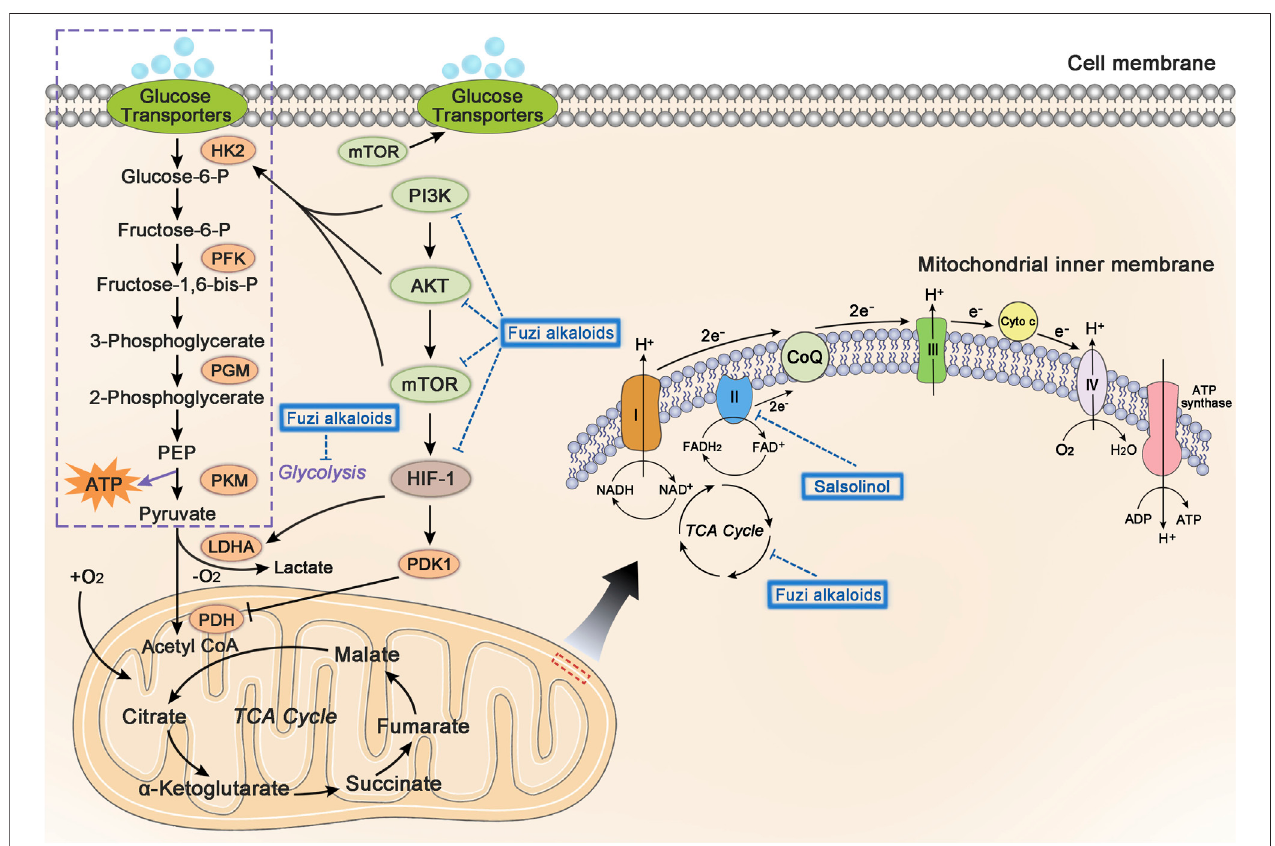
FIGURE7| Thein fl uenceofFuzialkaloidsoncancerenergymetabolism.Fuziregulatedtheenergysupplyofcancercells,aswellasinducedcelldeathbyinhibiting mitochondrial complex II, PI3K/AKT/mTOR pathway, HIF-1 pathway, and central carbon metabolism. The blue dotted arrow indicated the effect induced by Fuzi